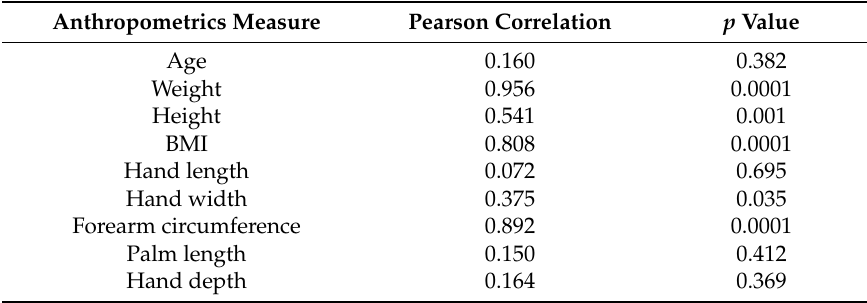
Table 6. Correlation between anthropometric data and grip strength.